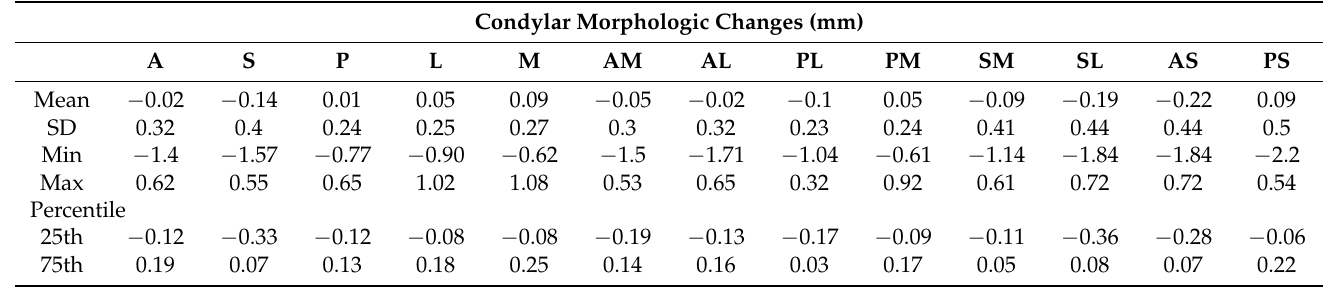
Figure 6. Means plots of the condylar surface changes on each surface area. Table 2. Descriptive statistics for condylar surface changes between T1 and T2